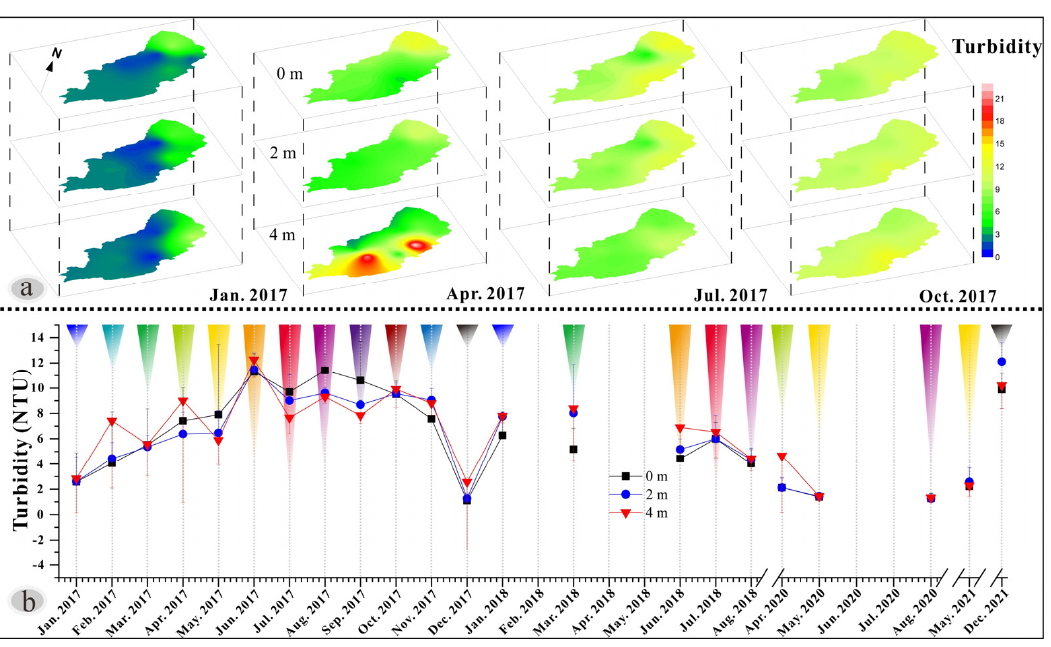
Figure 4. Seasonal variations in turbidity in Lake QL. ( a ) Temporal and spatial variation characteristics in turbidity; ( b ) Interannual variations in turbidity.